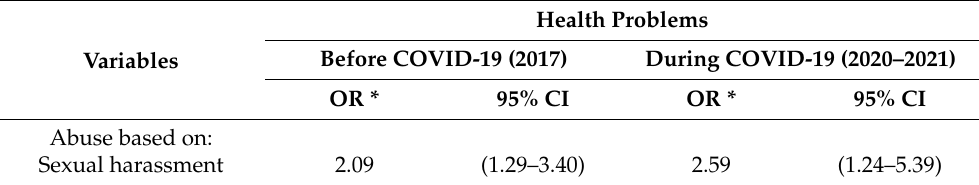
Table 3. The results of subgroup analysis of the association between sexual harassment and health problems in women.